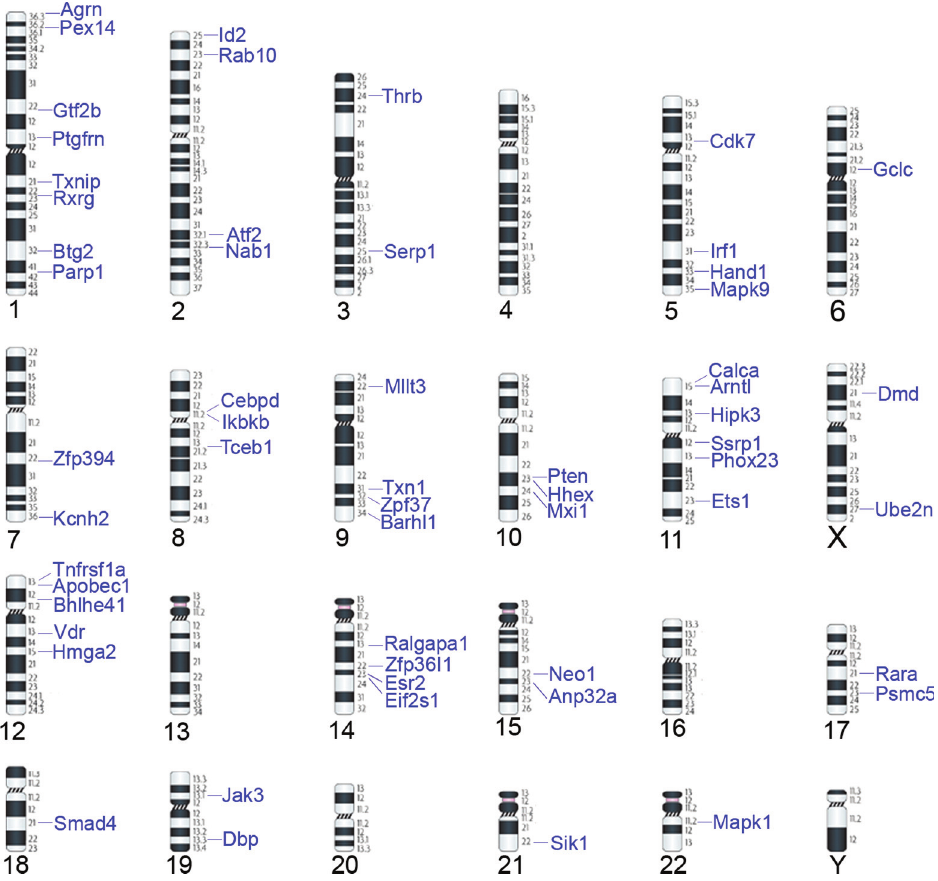
Figure2 -Mappingofthehumanorthologsof60TF/TRratgenestothehumanideogram.Indicatedaretheregionsofcopynumbergain(blue)andlosses (red) reported for healthy human individuals, according to Iafrate et al .